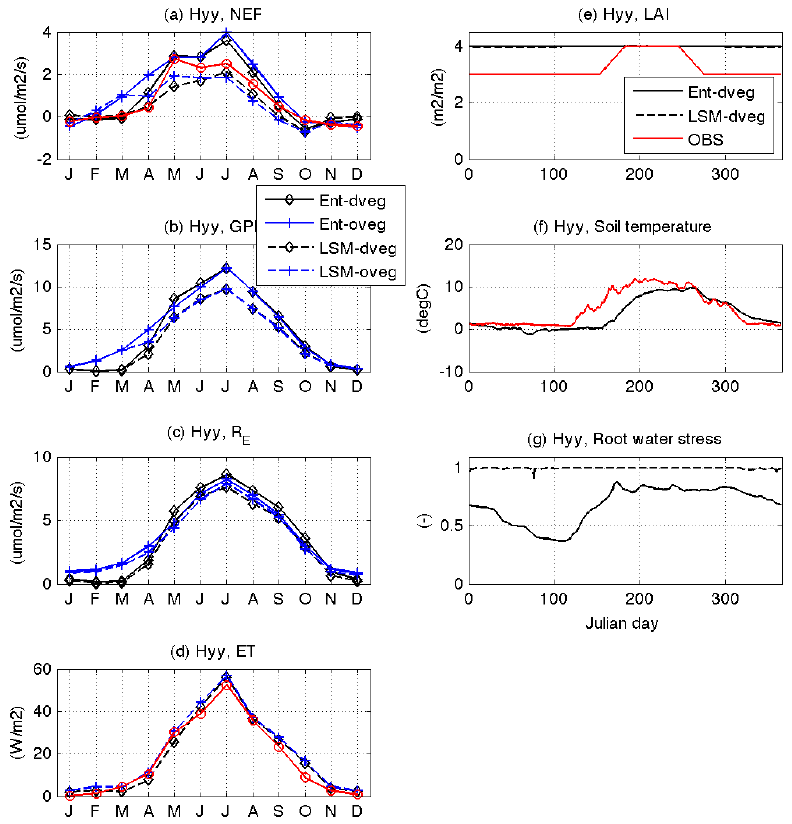
Figure 8. Monthly fluxes and daily states in Hyytiäla for 1998: (a) NEP, (b) GPP, (c) RE, (d) ET, (e) LAI, (f) soil temperature and (g) root water stress. Here the observed LAI is assumed based on personal communication with the site investigator, Pasi Kolari